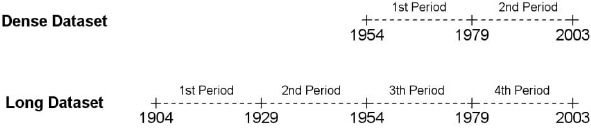
Fig. 5. Sub-period division of the two